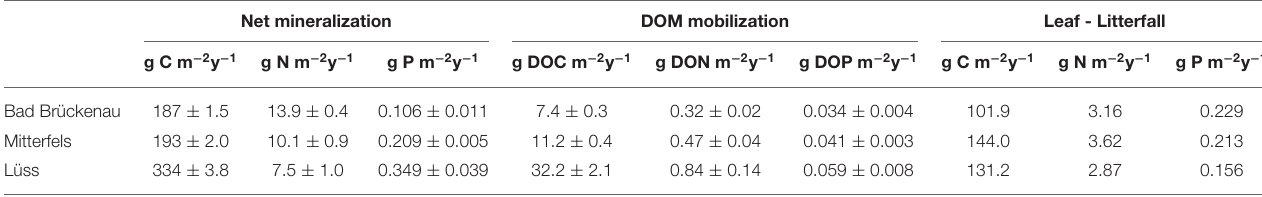
TABLE 4 | Estimates of annual net C, N, and P mineralization and mobilization of DOC, DON, and DOP from the Oi, Oe-Oa, and A horizon by multiplying measured mobilization rates with pool sizes and assuming that mobilization processes follow a typical temperature dependency with a Q 10 value of 3 (Conant et al., 2008). Net mineralization